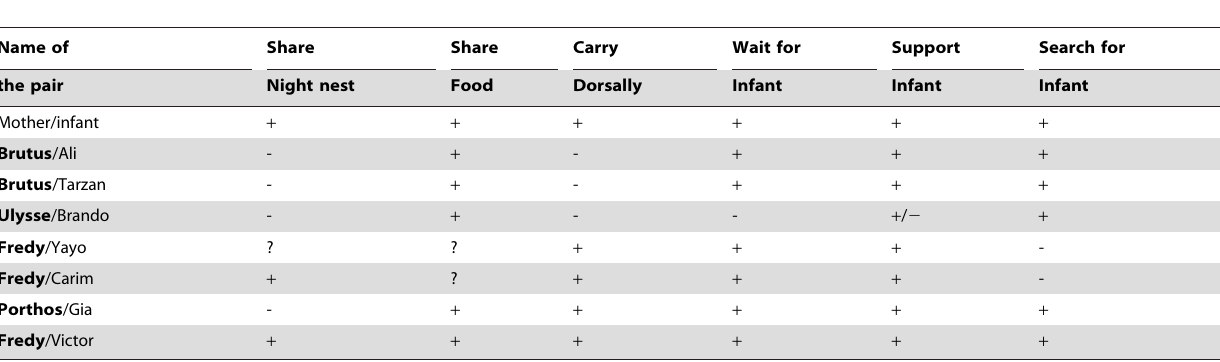
Table 3. Paternal-like behavior observed during an adoption by adult males (with the maternal investment as reference).